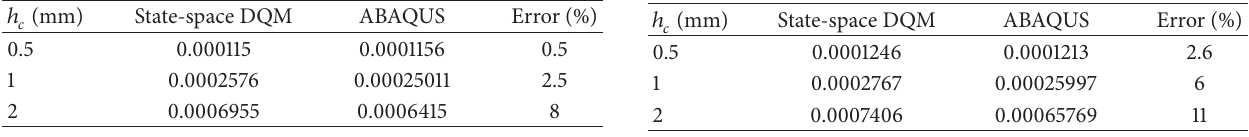
Table 4: Comparisonof thefrequency value associated with thefirst vibration mode for a clamped-clamped annular plate ( 𝑎 = 50 cm, 𝑏 = 5 cm, and 𝑚 = 0 ).